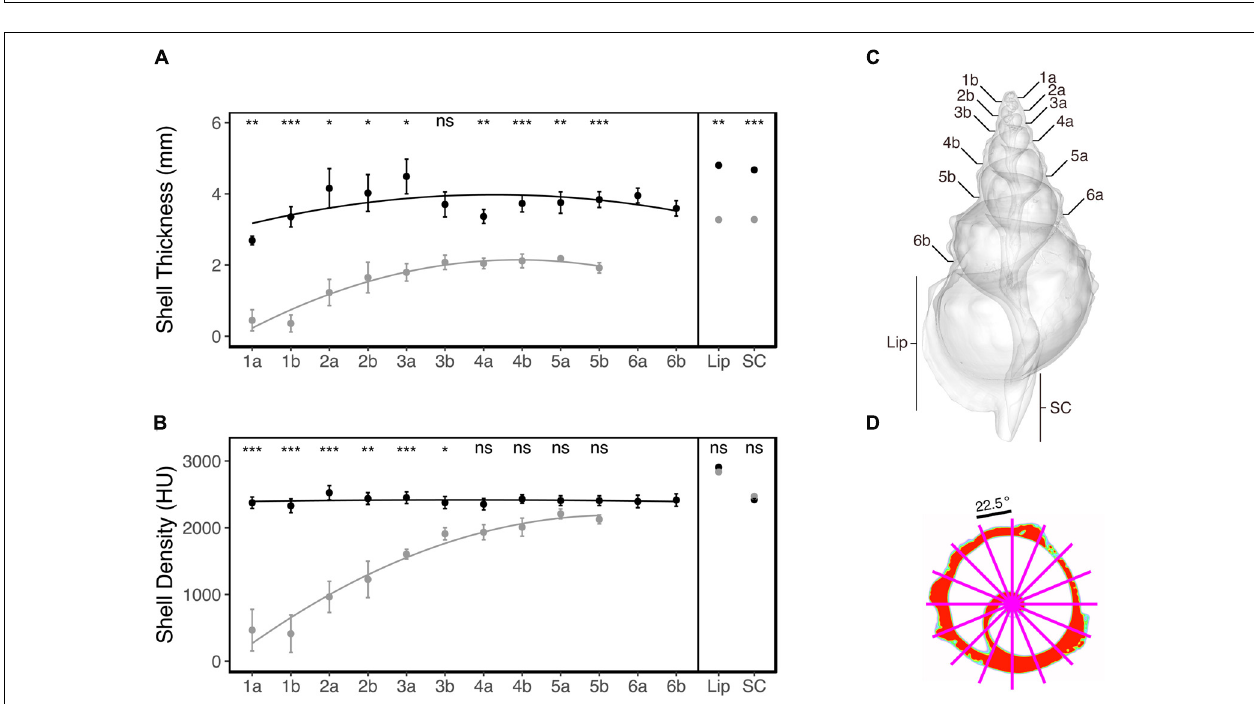
FIGURE 3 | Mean ( ± SE) shell thickness, mm (A) and mean ( ± SE) shell density, Hounsfield unit (HU) (B) of the control p CO 2 (solid black) and elevated p CO 2 (solid grey) individuals ( n = 10) across the different shell regions. Pairwise comparisons for the same shell region were tested using a Bonferroni-corrected t -test, with the test results indicated at the top as (ns, non-significant, ∗ p < 0.05, ∗∗ p < 0.01, or ∗∗∗ p < 0.001). The different shell regions (the dorsal “a” and ventral “b” sides of sutures 1–6, and the mid-points of the shell lip “lip” and siphonal canal “SC”) are defined for a representative individual (C) . Average density and thickness was obtained for each shell region by overlaying 16 equally spaced radii (22.5 ◦ ) from the centre of each slice, and extracting the mean density (HU) and thickness (mm) where the radii and shell intersected (D)